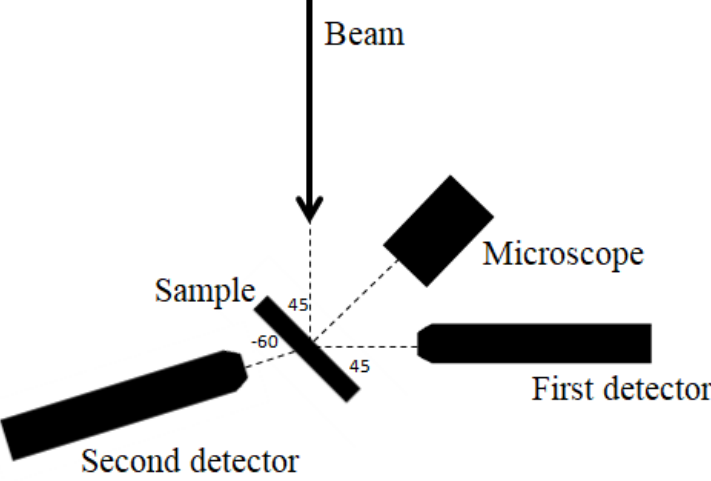
Figure 6. The scheme of the SR-XRF set-up used in the experiment. Measurement data were saved in NeXus files. Then, the PyMca program [16] was used to obtain the ROI image—an image based on the integral over the entire spectrum— on the basis of which a binary image was created for each map. In order to binarise the image, the maps were pre-processed with Gaussian blur and then the Otsu method was applied using the Python environment [17]. The obtained images were processed into a mask to automate the allocation of pixels to a specific irregularly shaped fibre. Based on the binary image, each pixel was assigned a specific number depending on its location. The intercellular space—i.e., endomysium—was marked with the number 0; the fibres that were not completely measured were left with the number 1 and the pixels that made up the fibres that were completely measured were assigned the next natural numbers. The created mask was used to isolate the pixels that make up the irregularly shaped fibre. For this purpose, an original script in the Python environment was created. Using the NeXus files and the mask, the script was able to extract the appropriate spectra assigned to a specific fibre, sum them up and save the final spectrum in a separate ASCII file. The obtained spectra were fitted using the PyMca program in order to obtain information about the net area under the peaks of individual elements such as Br, Ca, Cl, Cr, Cu, Fe, K, Mn, P, S and Zn. Those values were normalised in two steps: to the Compton scatter peak [18] area values to minimise the influence of the sample thickness and density variations, and to the number of pixels corresponding to each fibre. An exemplary spectrum is shown in Figure 7. The data prepared in this way were then subjected to statistical analysis in the STATISTICA program. Figure 8 shows graphically the individual steps of creating the